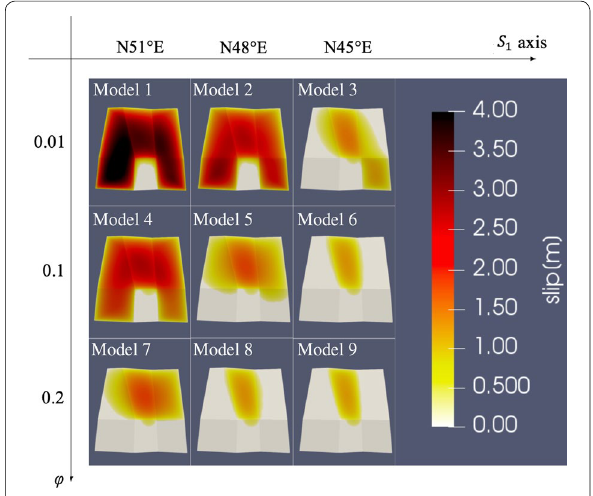
Fig. 11 Final distribution of slip for different stress parameters. View from the east